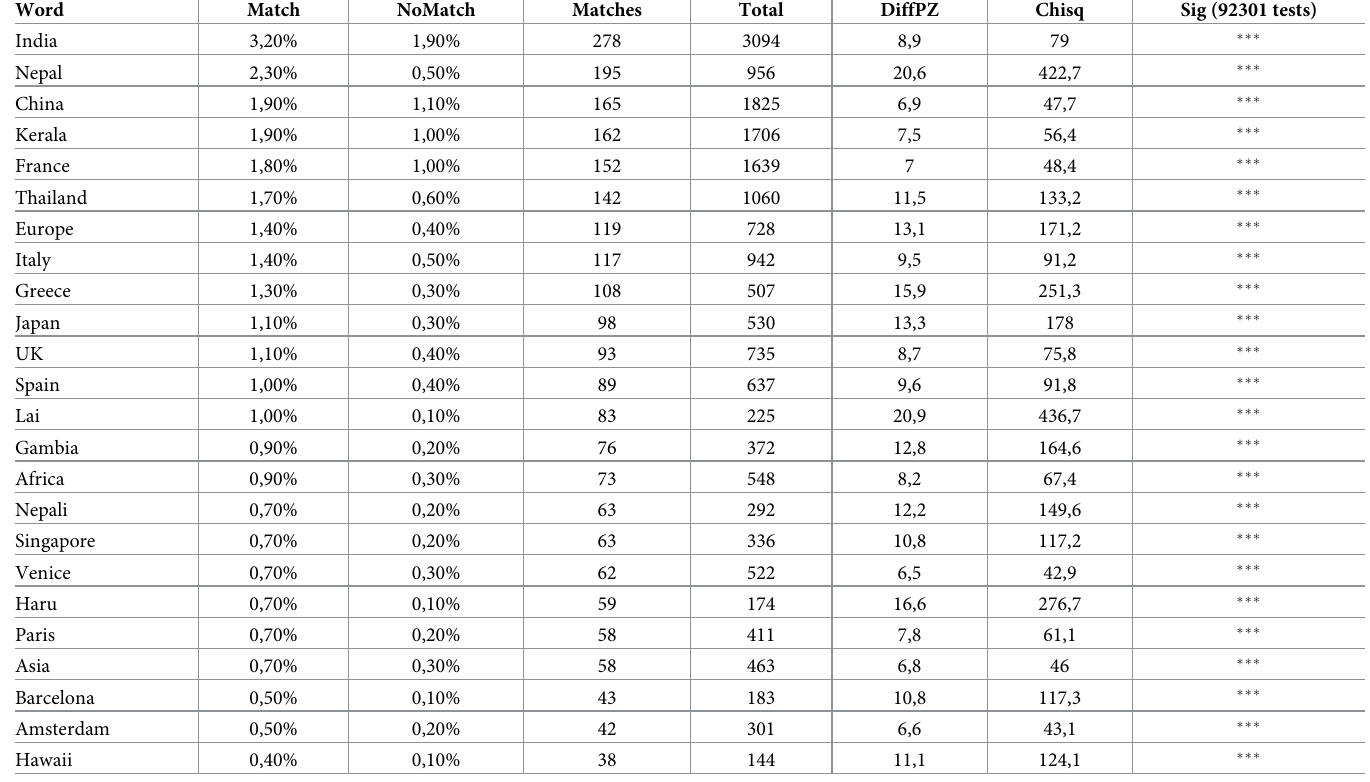
Table 3. Most frequent destinations mentioned in the comments of videos about tourism on